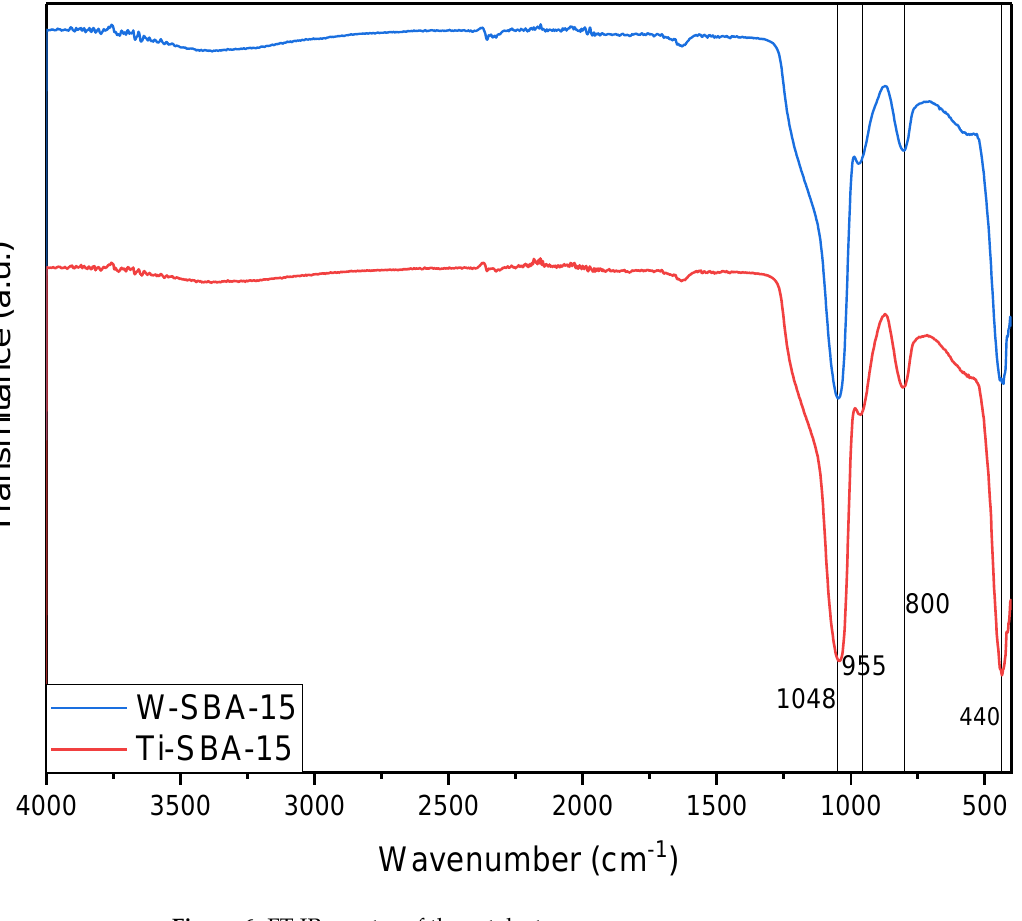
Figure 6. FT-IR spectra of the catalysts.